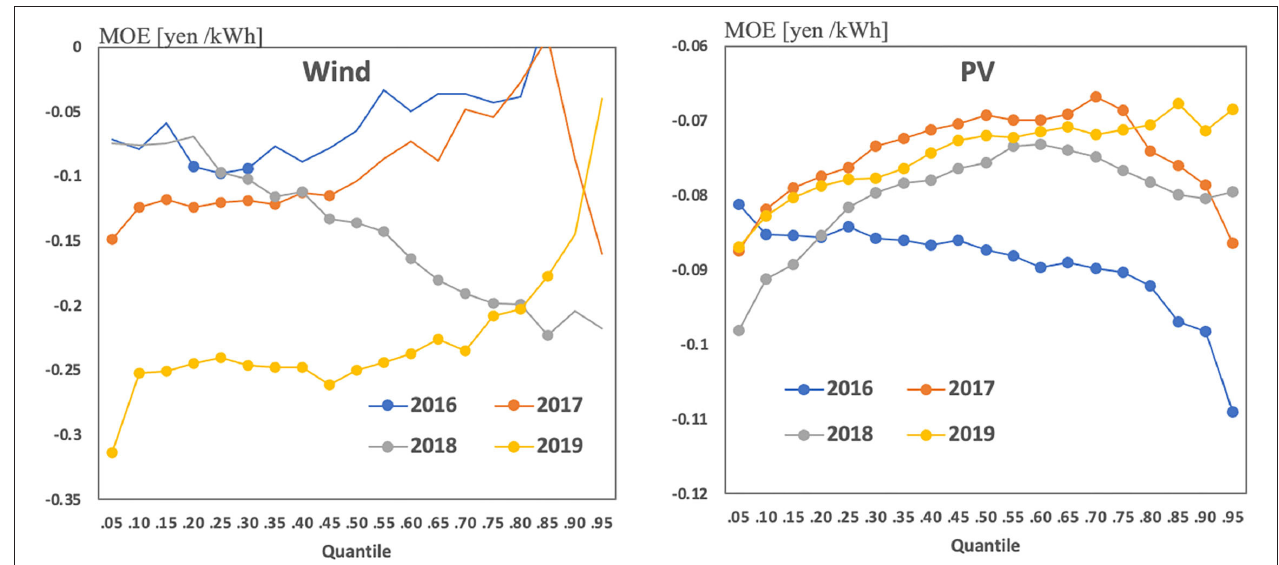
FIGURE 4 | The results of the quantile regression analysis of system prices. (Source: Created by author). The dots in the graph indicate significance at the 1%